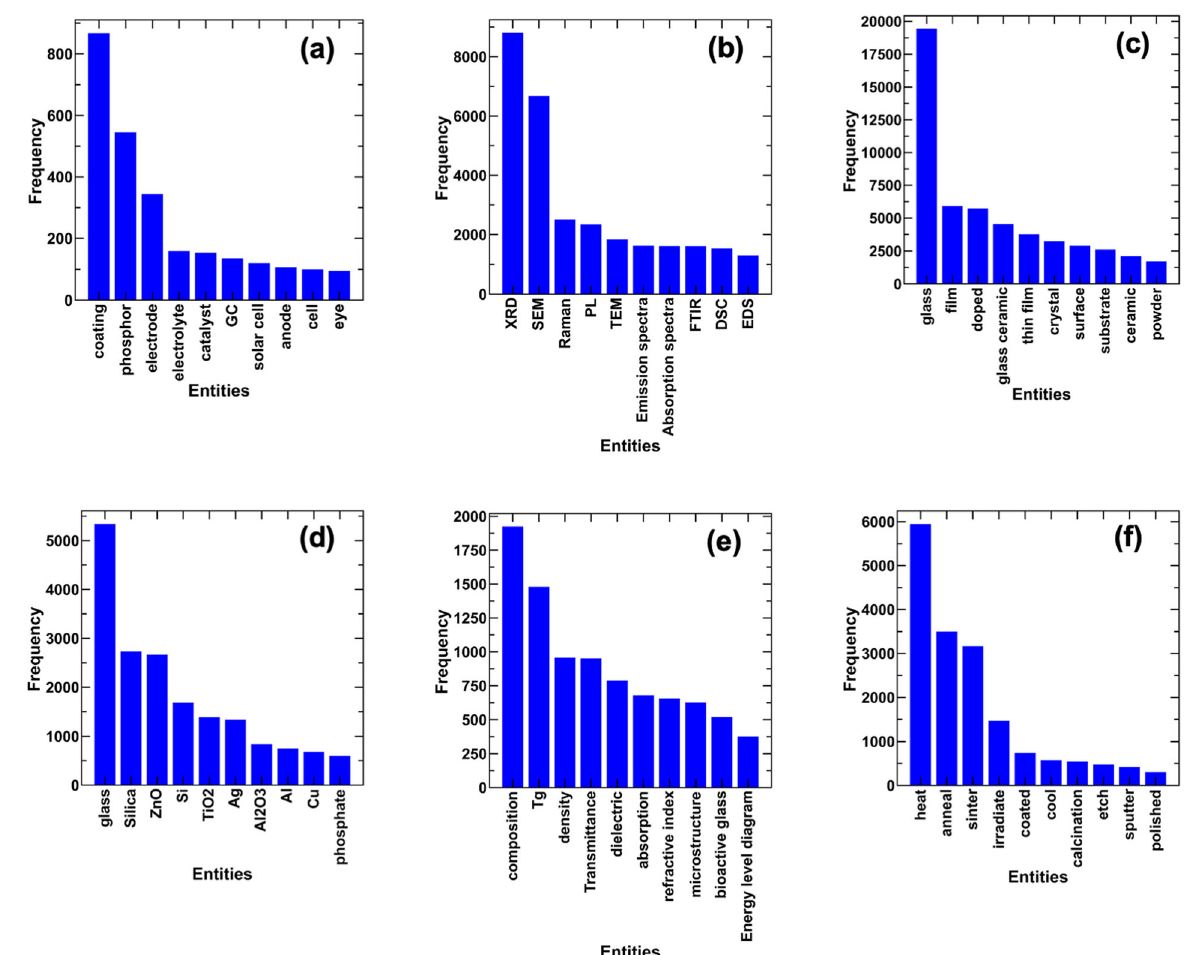
Fig. 3 Top-10 entities for various categories. a APL Application, b CMT Characterization method, c DSC Sample descriptor, d MAT Inorganic material, e PRO Material Property, and f SMT Synthesis